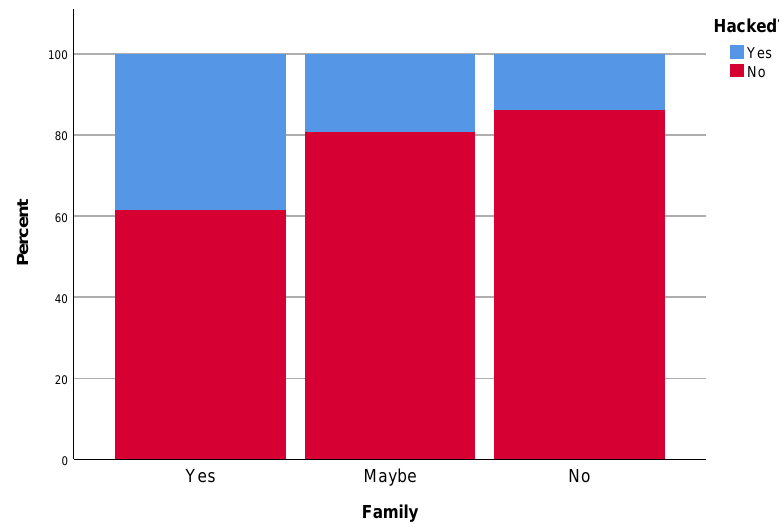
Figure 10. Susceptibility to clicking phishing messages coming from a family member sorted on those having suffered ID theft.